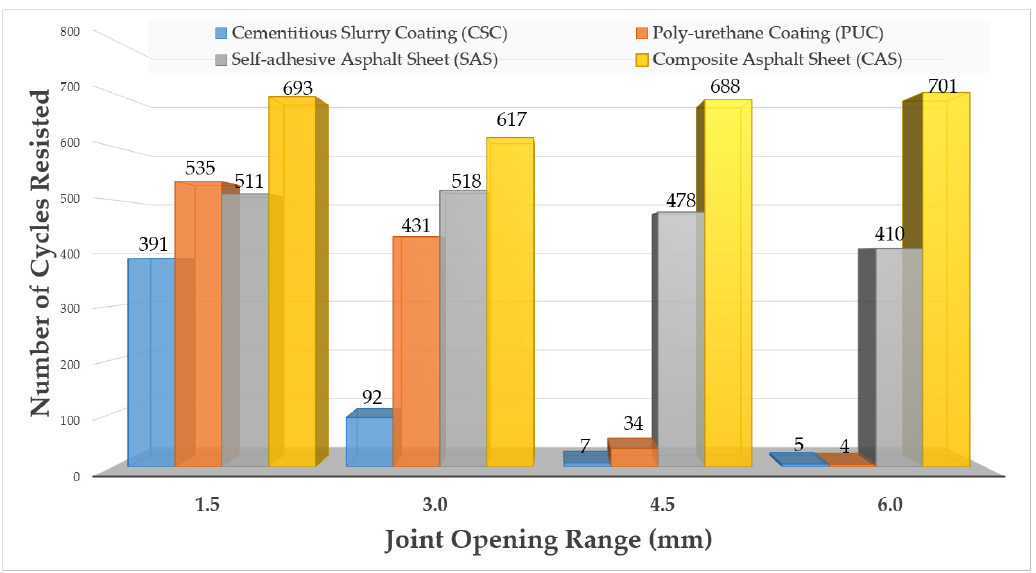
Figure 12. Joint opening resistance performance result of the respective waterproofing system types (per opening range).